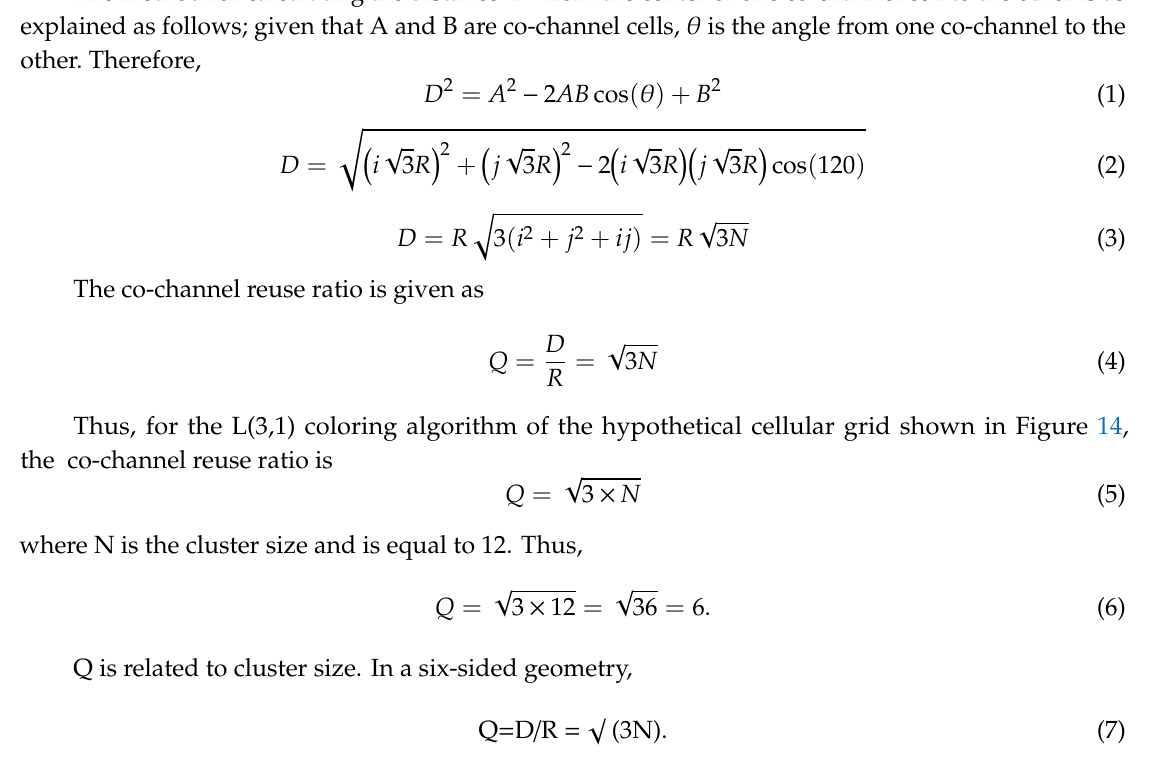
Figure 14. Description of cell cluster.